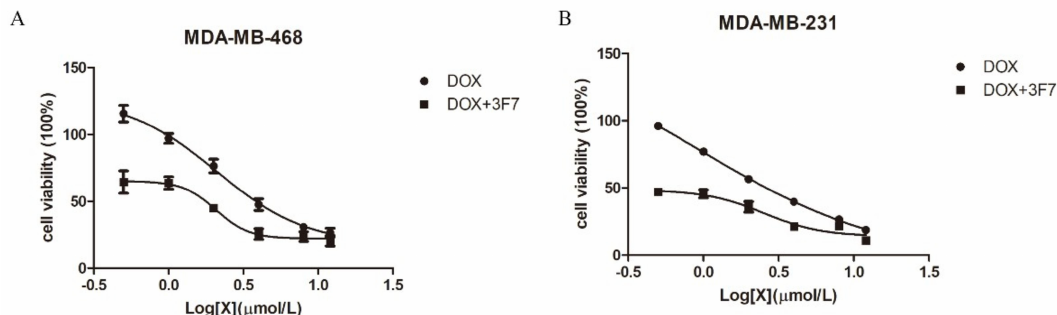
Figure 5. The 3F7 antibody enhanced the cytotoxic effects of Doxorubicin (DOX): ( A ) the proliferation of MDA-MB-468 cells in the presence of DOX with or without 3F7 mAb and ( B ) the proliferation of MDA-MB-231 cells in the presence of DOX with or without 3F7 mAb. Data were representative of at least three independent experiments and means ± SD were